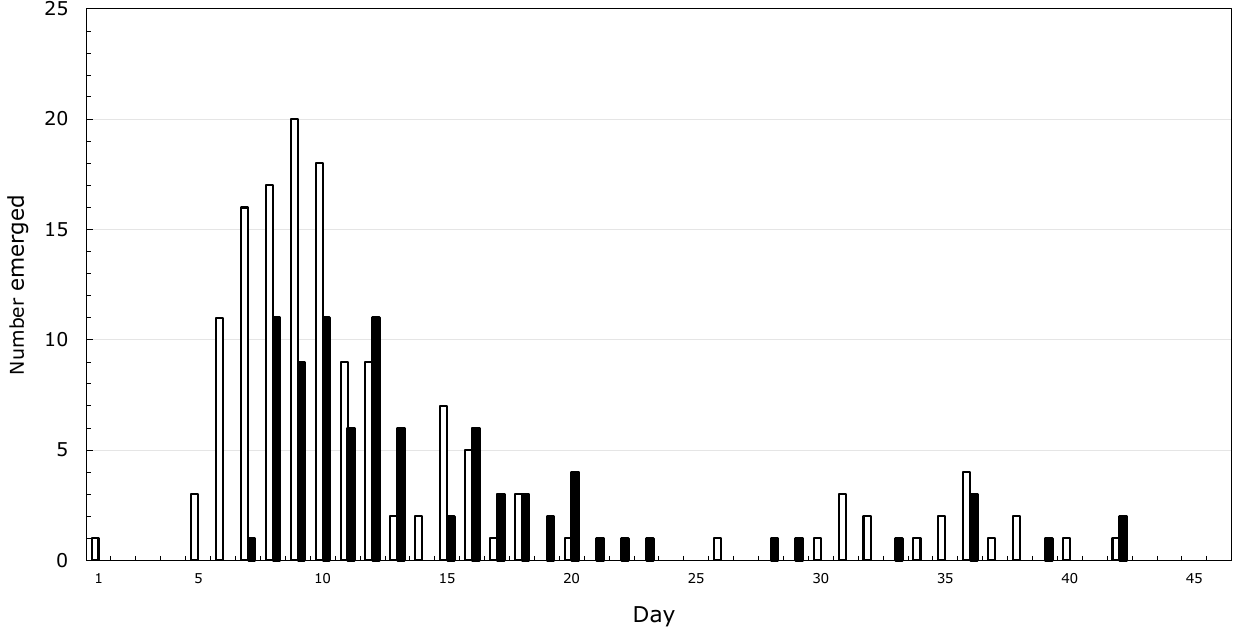
Figure 1. Emergence of Hyalophora cecropia moths from 1 June through 15 July 1965 in Pawcatuck, CT, USA. Open bars, males; closed bars, females.